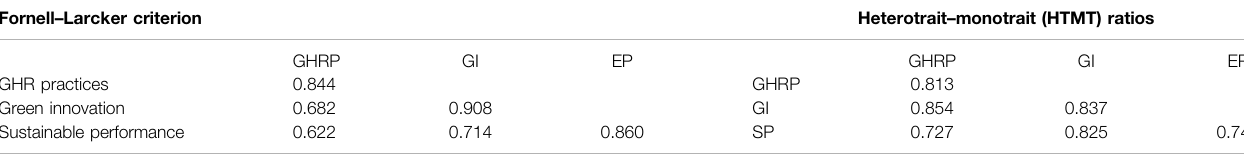
TABLE 3 | Discriminant validity.